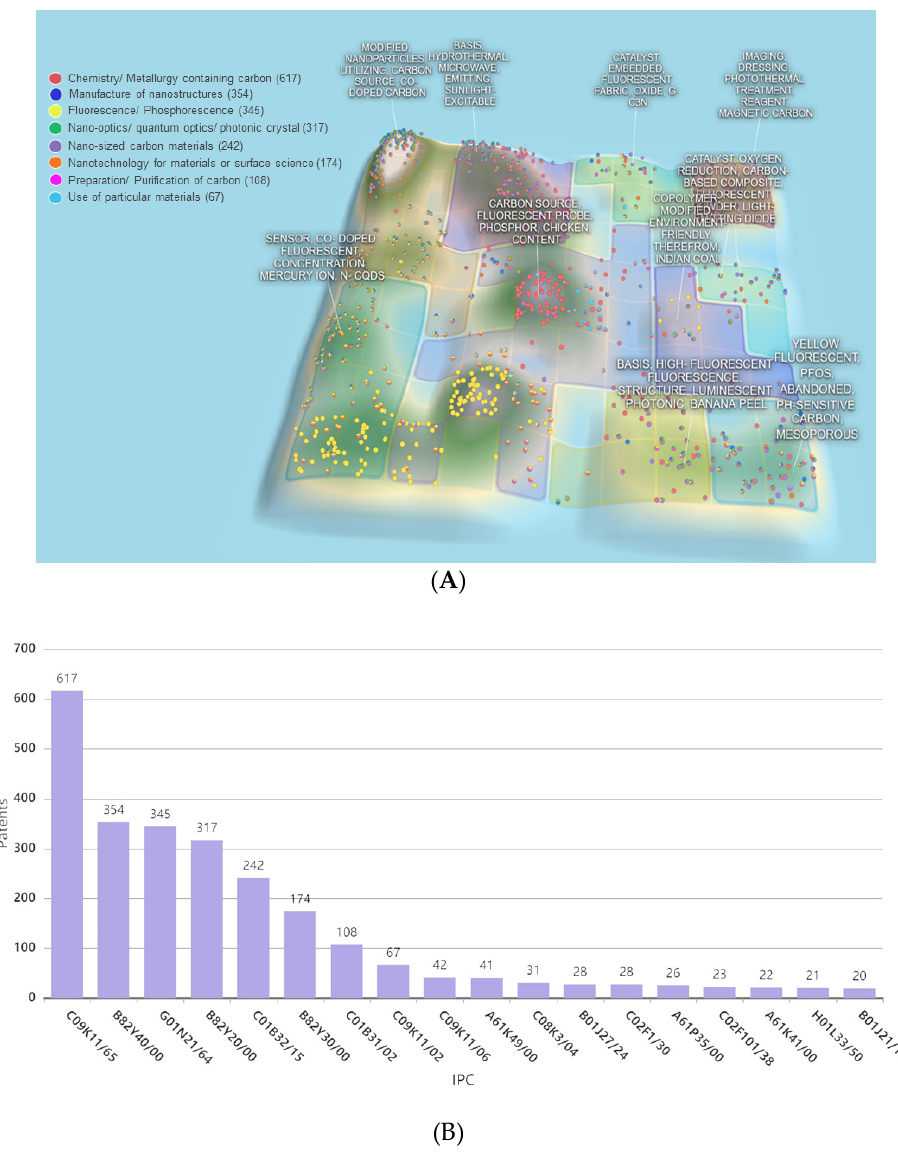
Figure 3. ( A ) Patent landscape on CDs and ( B ) the numbers of patent and patent applications according to the top international patent classification (IPC) groups analyzed by PatSnap in February 2020.